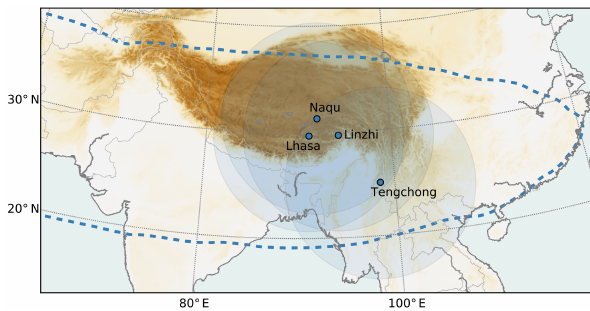
Figure 1. Locations of the radiosonde launch sites. The circular shaded areas cover a 1000km radius from each site. The dashed contour corresponds to the 16770gpm contour of 100hPa geopo- tential height from the ERA-Interim reanalysis, averaged over July and August 1979–2014. The shading indicates topography, with darker colours corresponding to higher surface